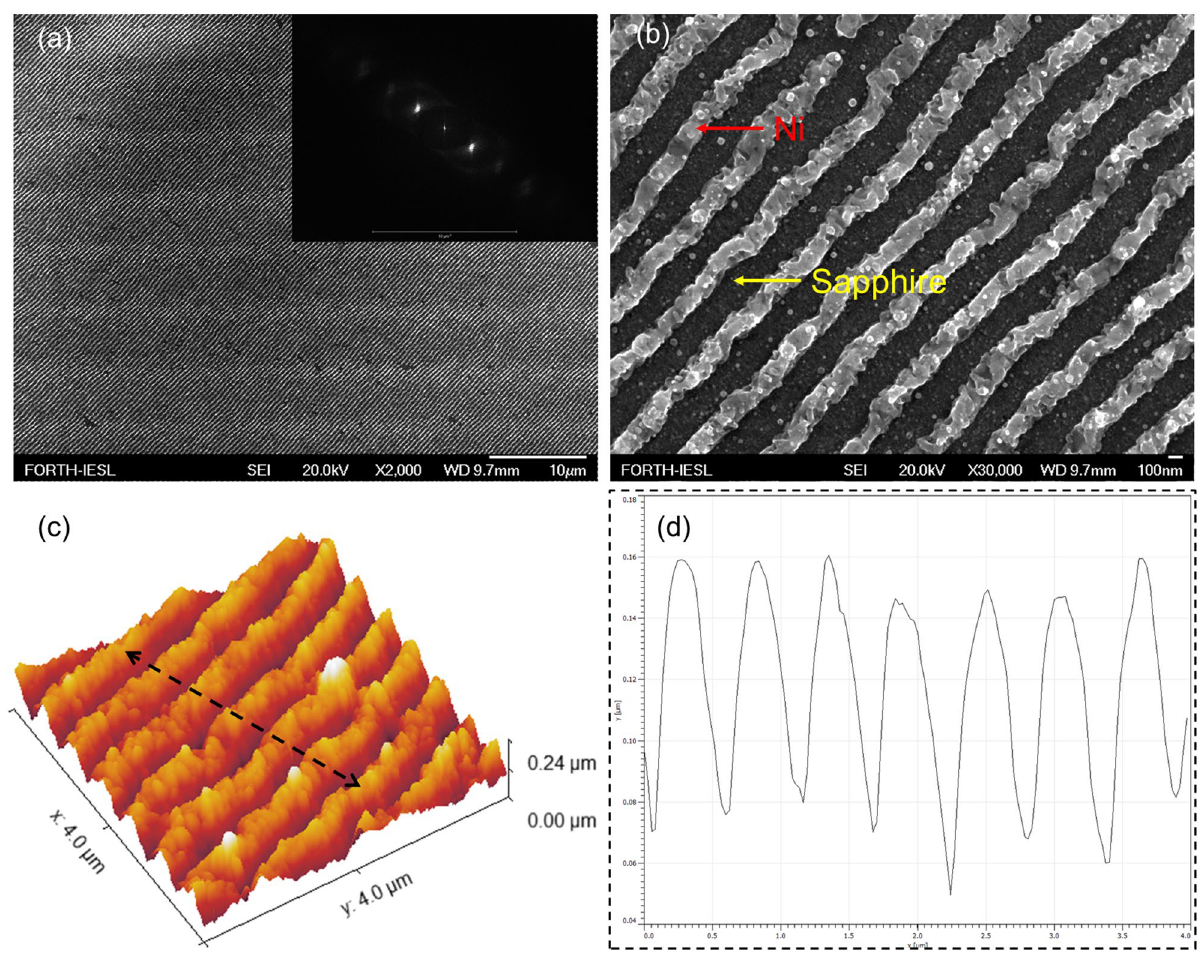
Figure 2. ( a ) Top view SEM image of the LIPSS formed on the thin Ni film, and ( b ) higher magnification. Inset in ( a ) shows the corresponding 2D-FFT. ( c ) Representative AFM image ( 4 × 4 μm) of LIPSS; ( d ) LIPSS cross- section along the double-ended arrow shown in ( c